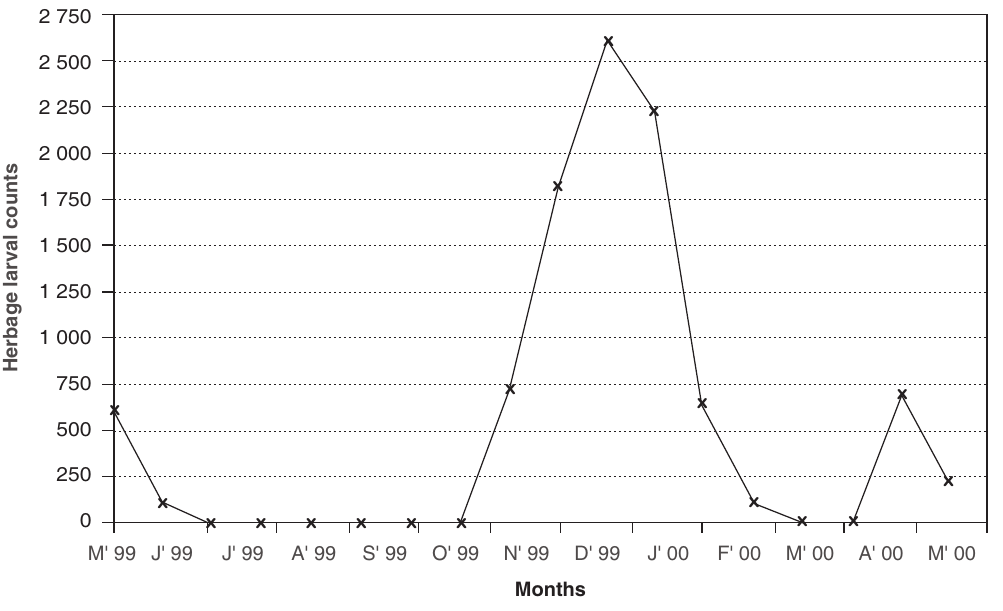
FIG. 4 Number of strongyle larvae per Kg of dry herbage recovered every 3 weeks from pastures grazed by Dorper sheep in a semi-arid area of Kajiado district during the period May 1999 to May